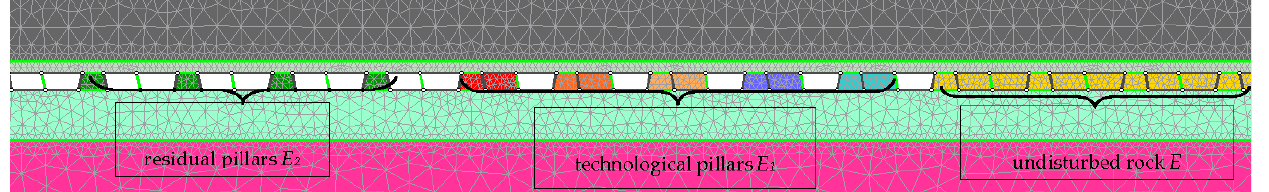
Figure 10. Intervals of confidence for a.